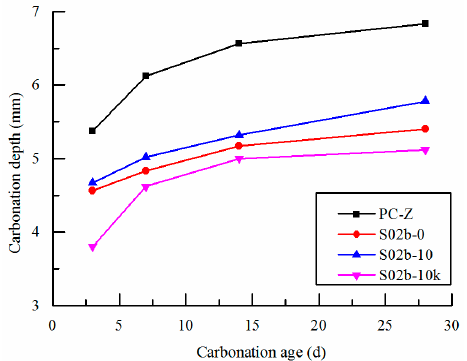
Figure 7. Effects of SAP on carbonation depth of concrete. S02b-10 and S02b-10K are pre-absorbed, and S02b-0 is non-absorbed.